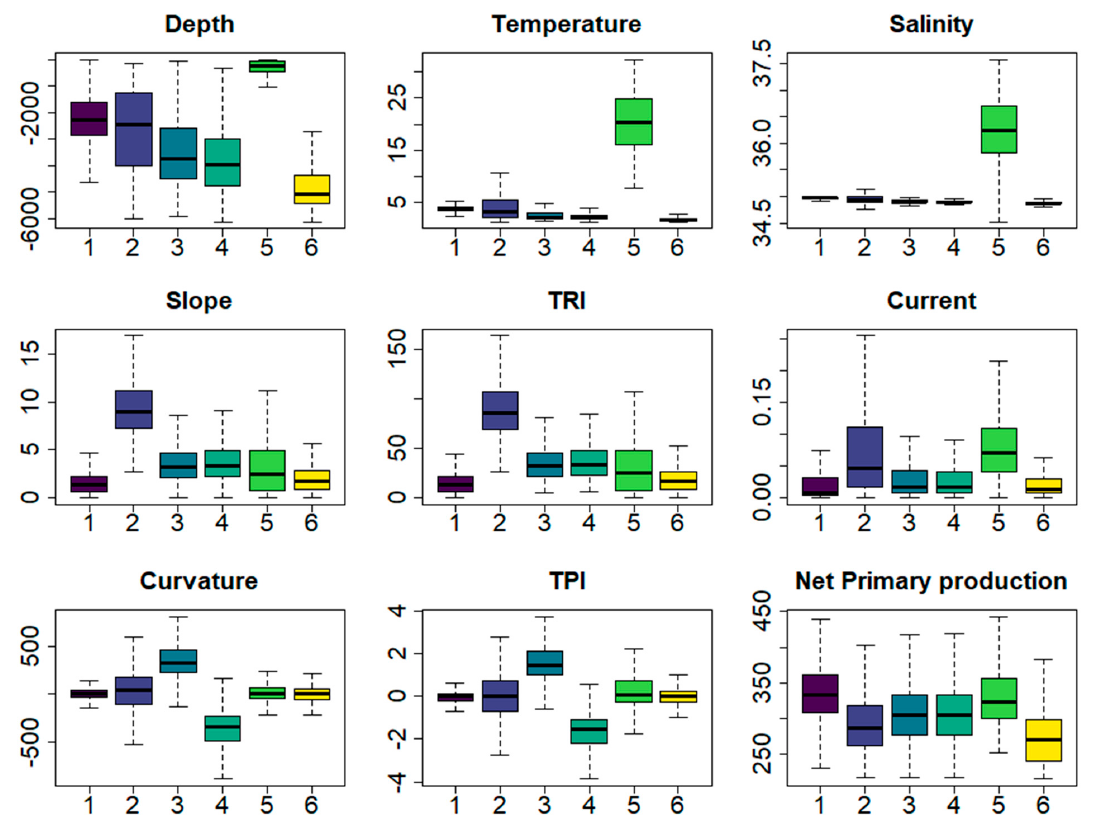
Figure 4. Boxplots of the nine original abiotic variables for each of the K-means derived clusters for the larger study area using three eigenvalues. The x-axis denotes the five K-means clusters, the y-axis denotes the respective units of each abiotic variable. The colours represent the corresponding cluster in the landscape map (Figure 3). In each plot, the line in the middle of the box represents the median, while the upper and lower extents of the box represent the first and third quartiles and the lines extending parallel from the box show the maximum and minimum values for each variable.